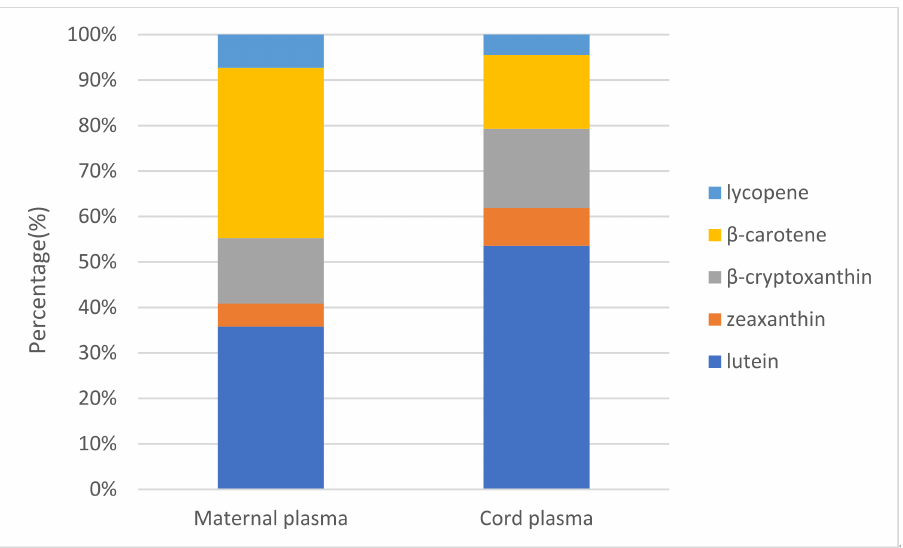
Figure 1. Proportions of carotenoids in plasma ( n =